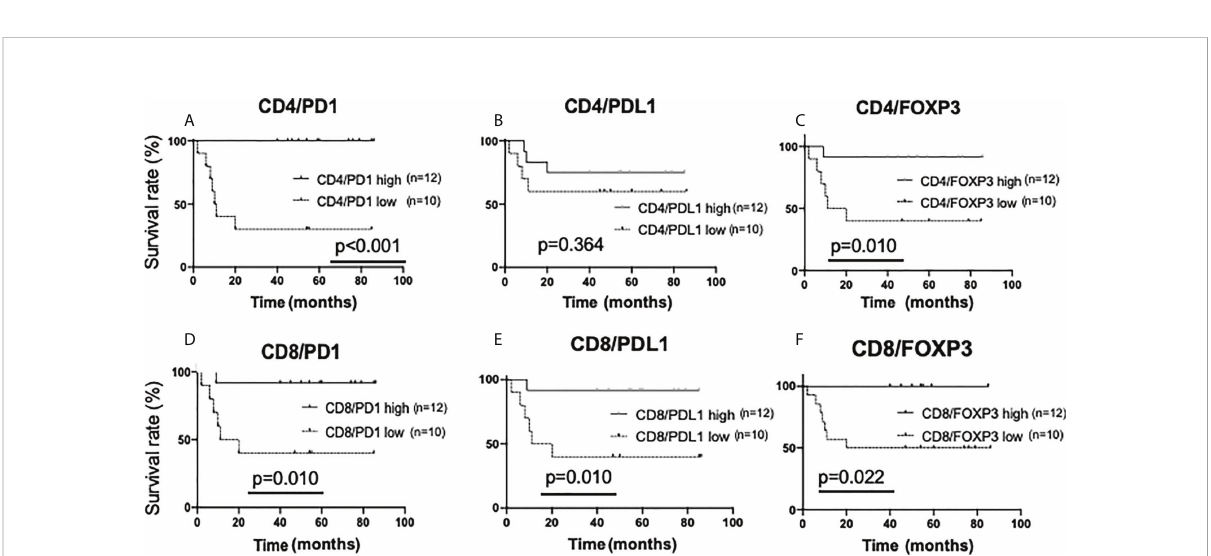
FIGURE 6 Kaplan-Meier analysis for recurrence-free survival categorized by the amount of stromal TIL (sTIL) marker double-positive cells in triple-negative cases. In TN subtypes (n=22), each sTIL marker was classi fi ed into “ low ” (n=10) and “ high ” (n=12)and analyzed as follows. (A) CD4/PD1-double positive sTIL low; <80 cells, high; >=80 cells, (B) CD4/PDL1-double positive sTIL low; <50 cells, high; >=50 cells, (C) CD4/FOXP3-double positive sTIL low; <60 cells, high; >=60 cells, (D) CD8/PD1-double positive sTIL low; <120 cells, high; >=120 cells, (E) CD8/PDL1-double positive sTIL low; <85 cells, high; >=85 cells, (F) CD8/FOXP3-double positive sTIL low; =<0 cells, high; >0